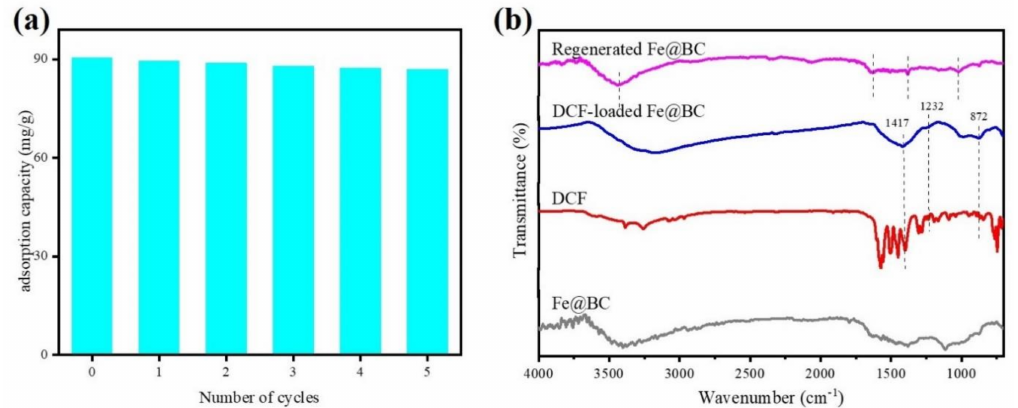
Figure 15. ( a ) Recyclability of Fe@BC for adsorption of DCF from aqueous solution and ( b ) FTIR spectra of Fe@BC, DCF, DCF-loaded Fe@BC, and regenerated Fe@BC.